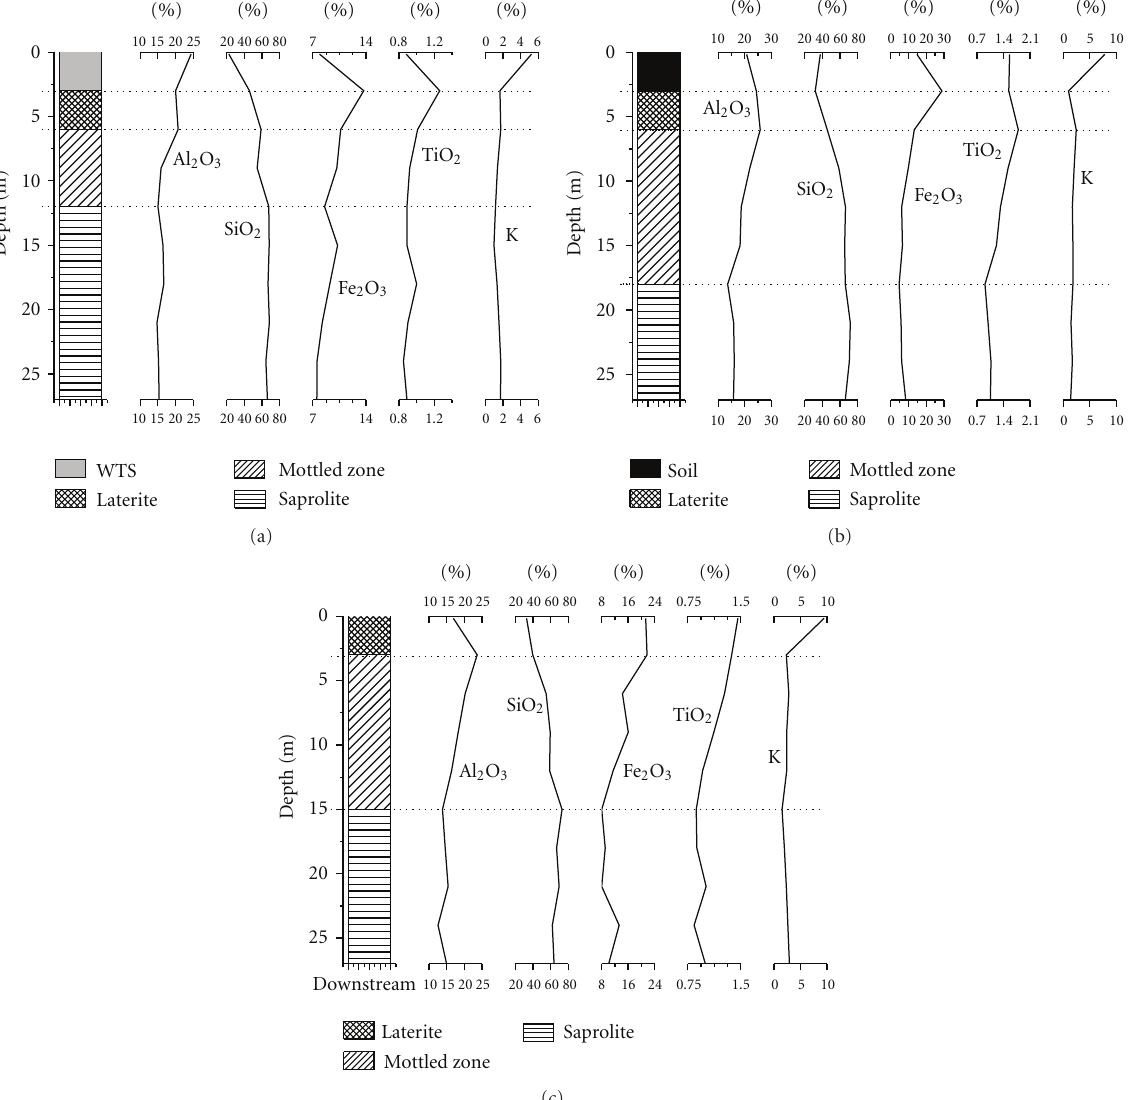
Figure 4: Hierarchical classification of samples extracted from the research well drillings. Analyses of major elements, mostly in the form of oxides, were placed in parallel to indicate the diagnostic horizons. (a) WTS well, (b) upstream well, and (c) downstream well.